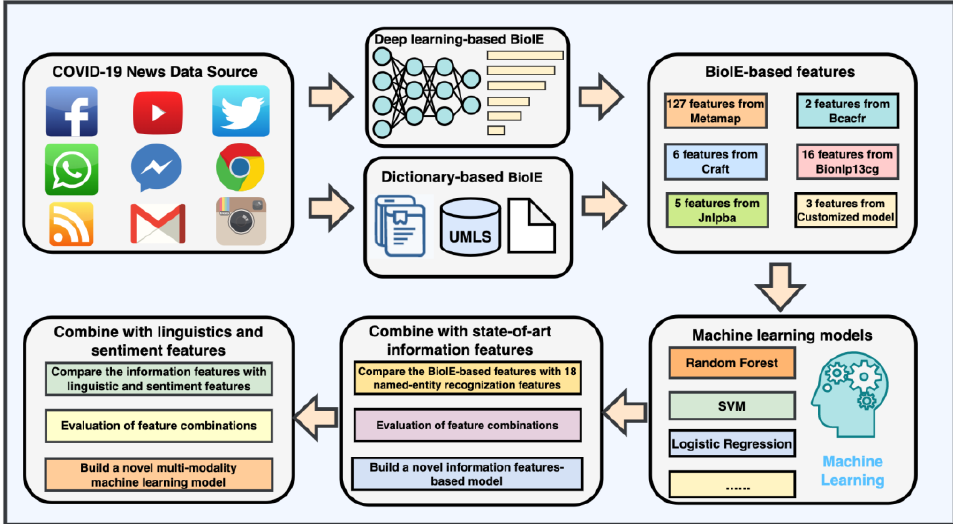
Figure 2. Flowcharts of the study.